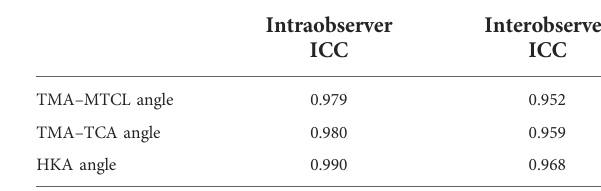
TABLE 1 Intraclass correlation coef fi cient of interobserver and intra- observer error of all